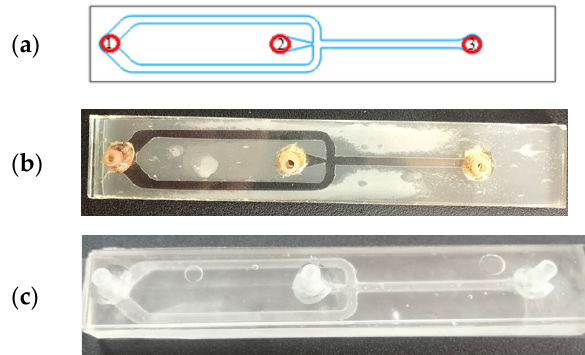
Figure 2. Microfluidic devices: ( a ) the configuration of the microchannel; ( b ) a sample of the chip made based on sandwich structures; ( c ) a sample of the chip produced by ESCARGOT technology.